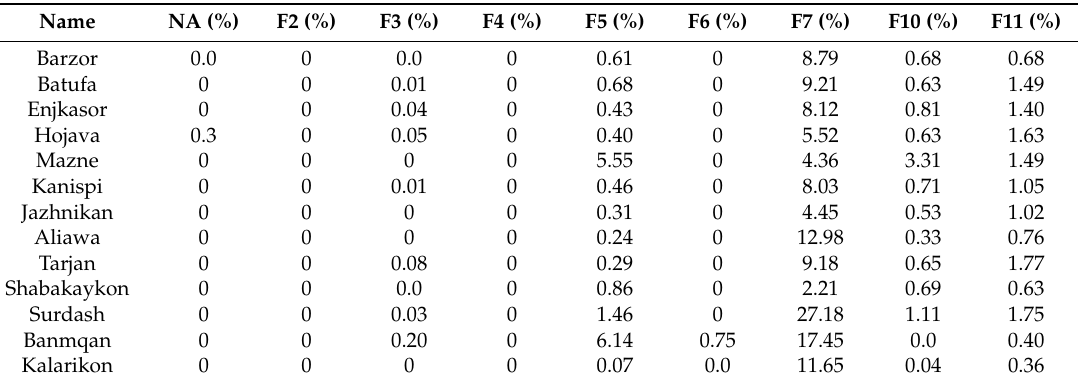
Table 5. The ratio of NA and the error flags in the tower station